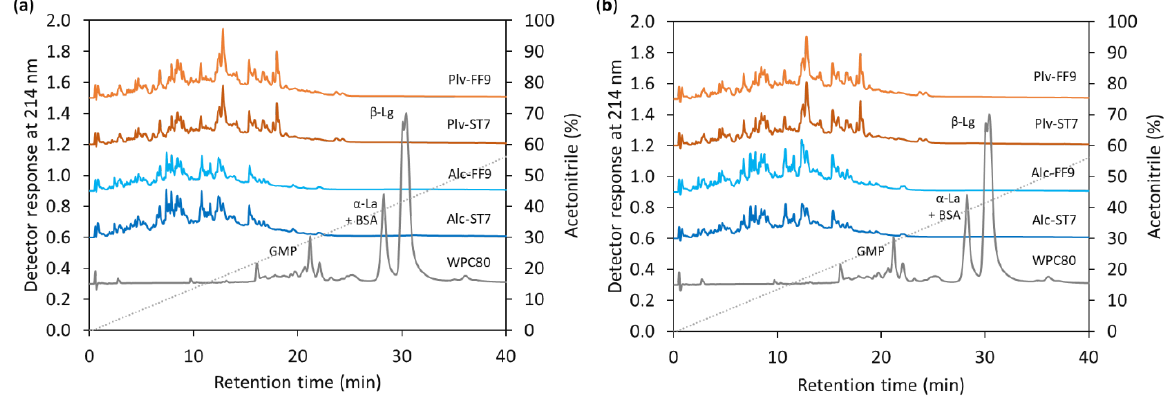
Figure 4. Reverse-phase ultra-performance liquid chromatographic profiles of whey protein concentrate (WPC80) and ( a ) spray-dried and ( b ) freeze-dried whey protein hydrolysates prepared using Alcalase ® (Alc) and Prolyve ® (Plv) obtained under pH-stat at pH 7.0 (ST7) and free-fall pH 9.0 (FF9) hydrolysis conditions. β -Lg: β -lactoglobulin; α -La: α -lactalbumin; BSA: bovine serum albumin; GMP: glycomacropeptide.